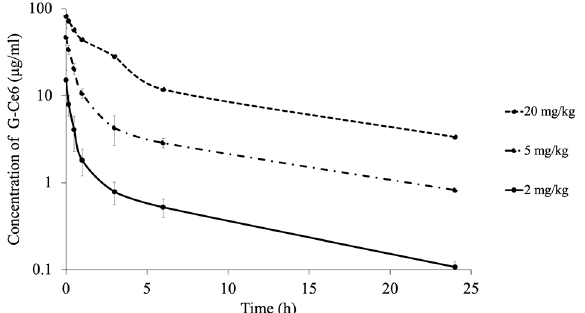
Figure 15. The mean concentrations of glucose-conjugated chlorin e6 (G-Ce6) in the plasma after intravenous administration of three doses of G-Ce6. The volume of G-Ce6 required to achieve the desired doses was diluted with 0.5% saline to obtain a total injection volume of 10 mL. The full injection volume was administered intravenously over 10 min at a rate of 60 mL / h; 2 mg / kg ( n = 6), 5 mg / kg ( n = 3), and 20 mg / kg ( n = 1).